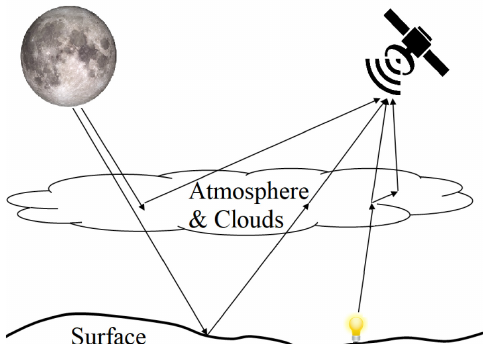
Figure 4. Model for night-time satellite